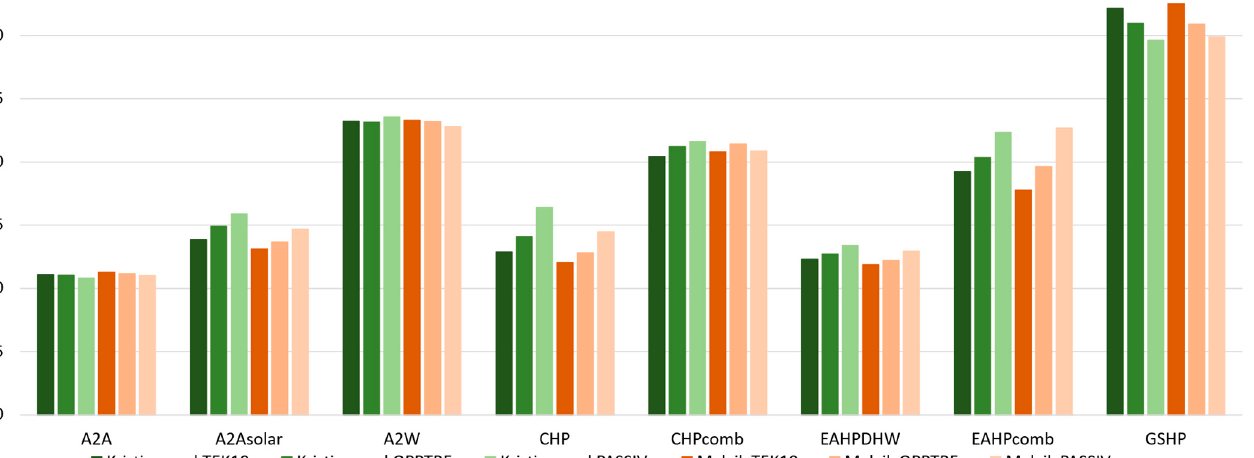
Figure 4. Energy coverage factor of the heat pump systems in both houses.